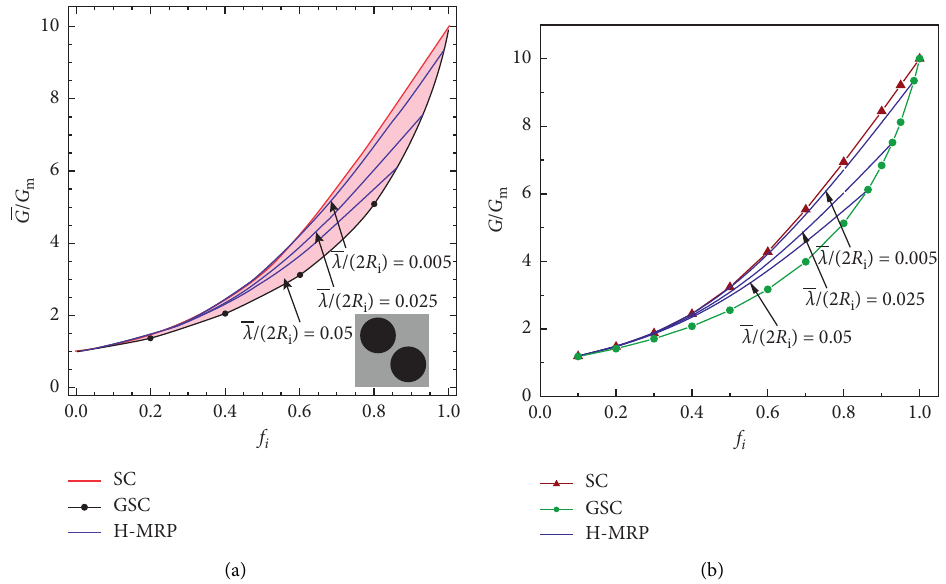
Figure 3: Predictedresultsofthemicromechanicalmodelunderdifferentparticledistributioncoefficients.(a)MRPmodel[29].(b)H-MRPmodel